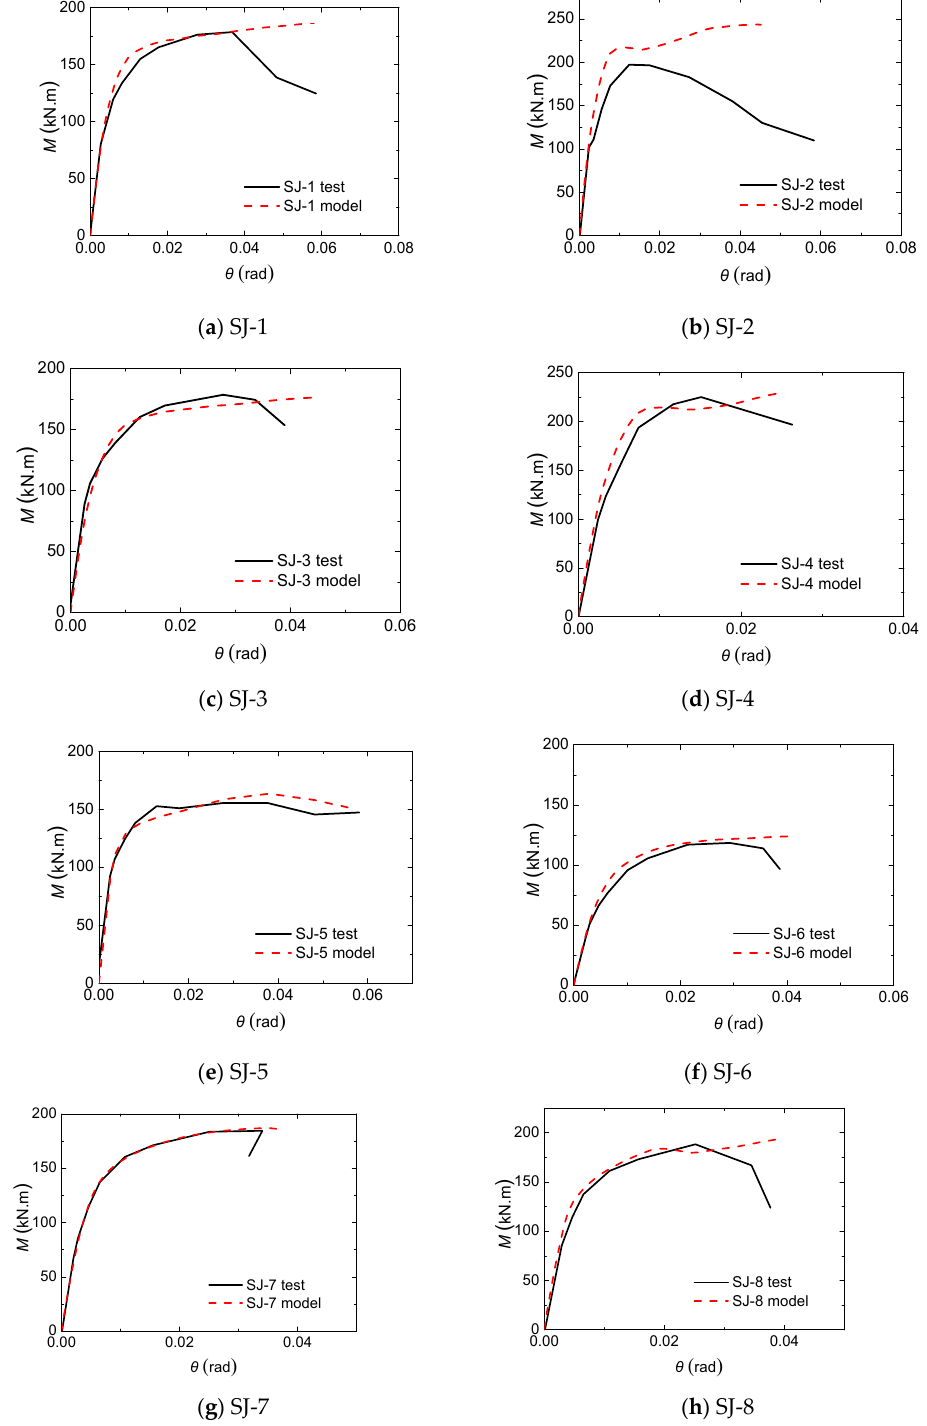
Figure 25. Comparison of experimental and simulated moment-rotation curves. ( a ) SJ-1; ( b ) SJ-2; ( c ) SJ-3; ( d ) SJ-4; ( e ) SJ-5; ( f ) SJ-6; ( g ) SJ-7; ( h )